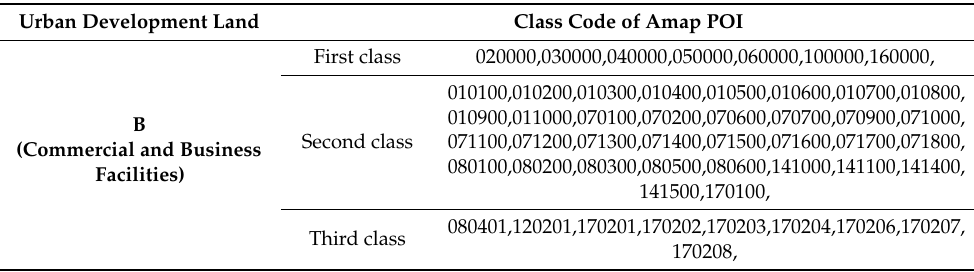
Table 2. The set of containment